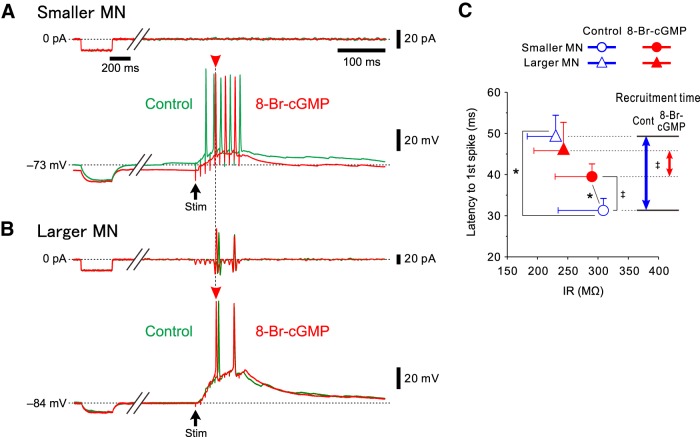
8-Br-cGMP differentially modulates spike-onset latencies between smaller and larger MNs in the dl-TMN. A, B, Membrane potential responses to hyperpolarizing current injections and those evoked by 100 Hz stimulation of presumed Ia afferents in smaller and larger MNs (A and B, respectively) obtained before (green traces) and during the application of 8-Br-cGMP (red traces). C, The relationship between the IRs and the latencies to first spikes obtained before and after the application of 8-Br-cGMP in four pairs of MNs of different sizes. The blue and red double-headed arrows represent the recruitment time, calculated as the difference in the mean latency to the first spike between the smaller and larger MNs obtained before and after the application of 8-Br-cGMP, respectively. *p < 0.05, Wilks’ lambda; ‡p < 0.05, paired t test.